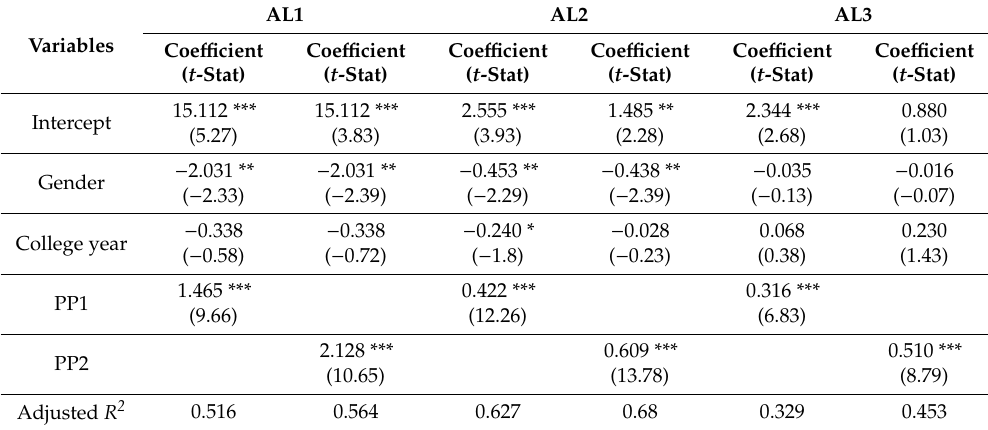
Table 7. E ff ect of positive perception on accounting